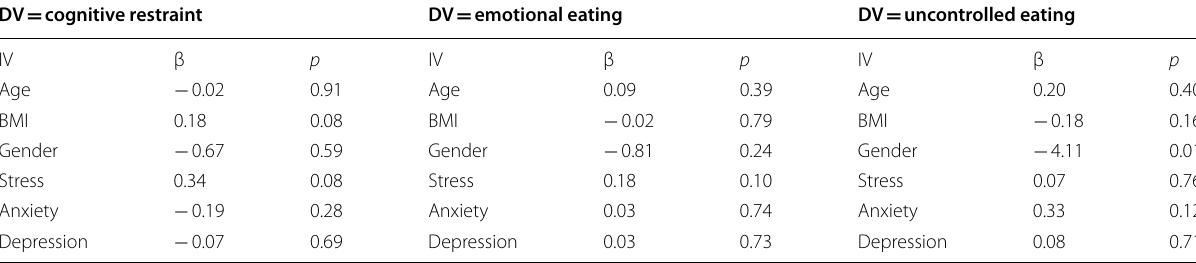
Statistics: Tables report General Linear Models of eating behavioural traits by psychological factors DV dependent variable, IV independent variable, BMI body mass index, β beta-coefficient